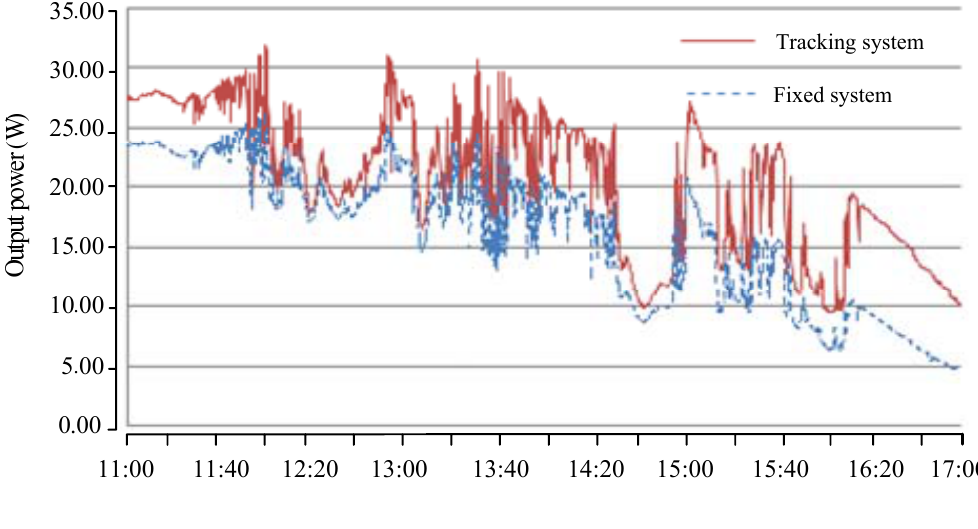
Figure 11. Comparison of the generating powers for the tracking and fixed